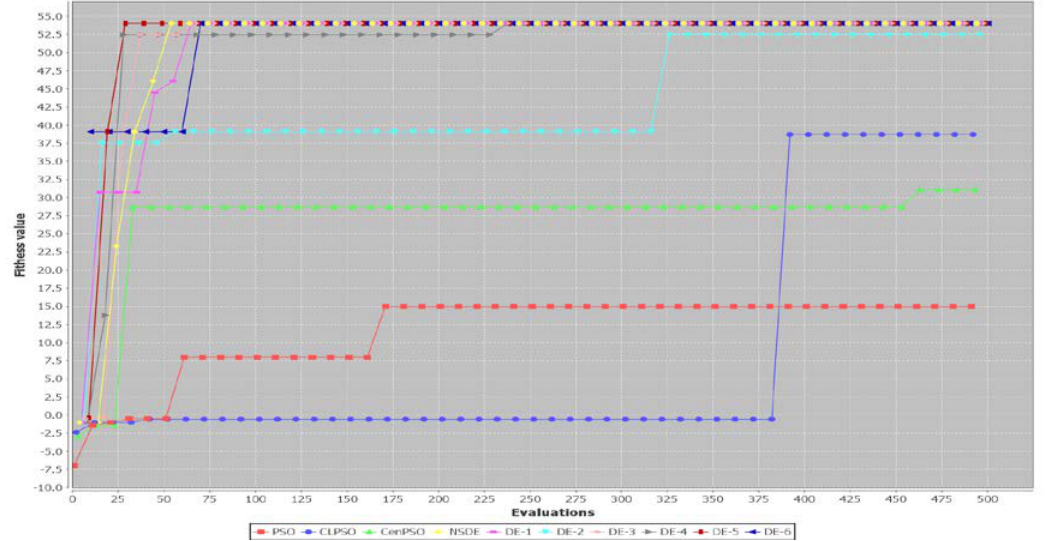
Figure A8. Convergence speed of a run of each algorithm for Case 8 with POP = 30.